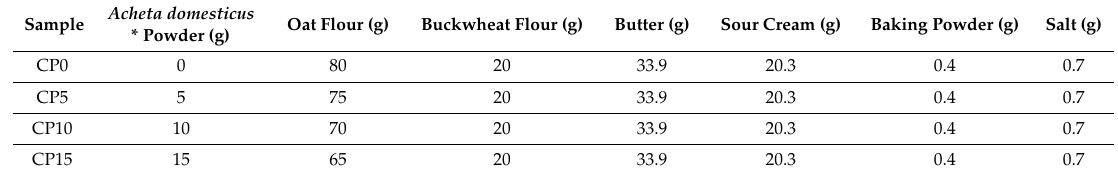
Table 1. The composition of the evaluated biscuits. The amount of ingredients is expressed per 100 g of flour mixtures.